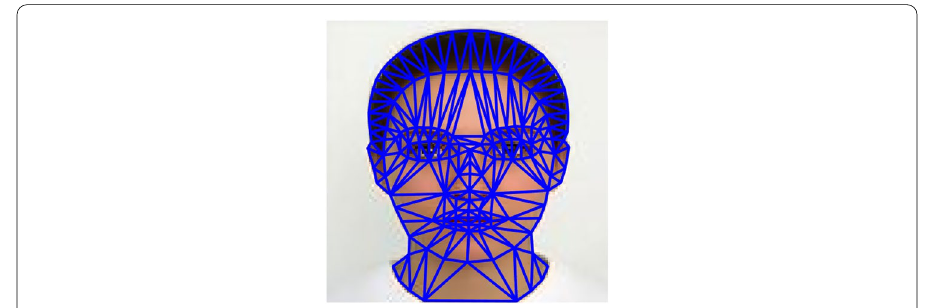
Fig. 5 An example of constructing triangle areas using landmark